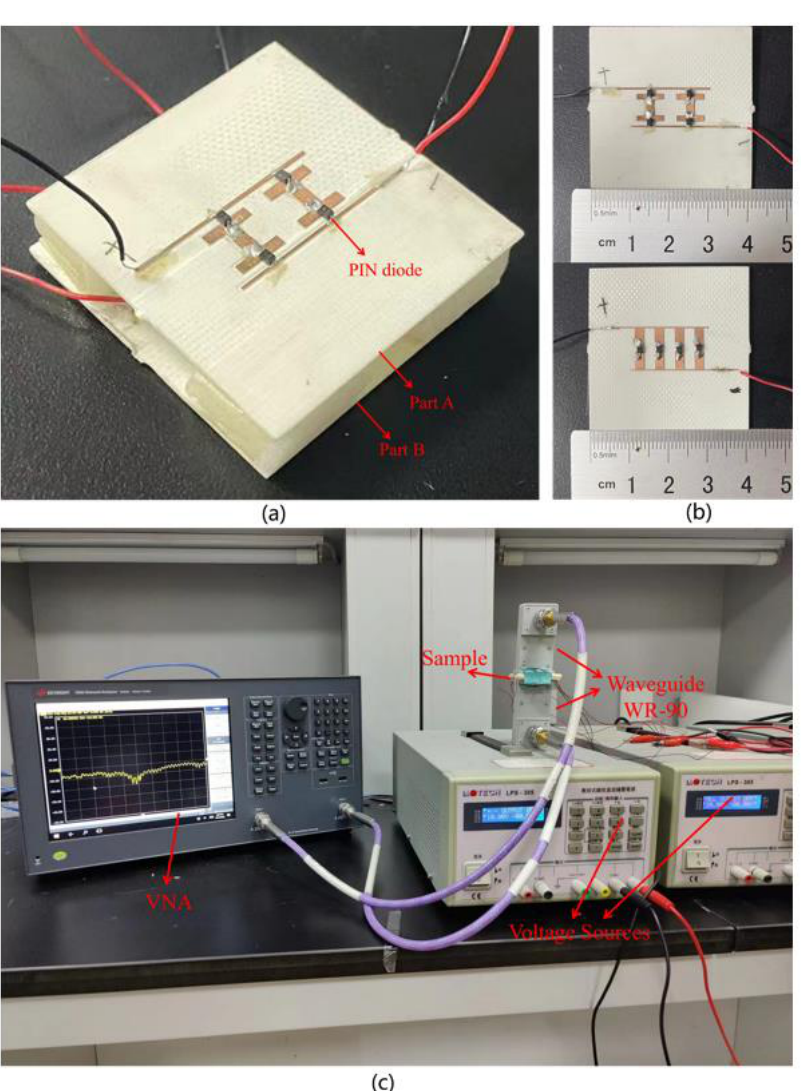
Figure 7. ( a ) Photographs of the fabricated prototype; ( b ) Top view of part A and part B; ( c ) Measurement setup.